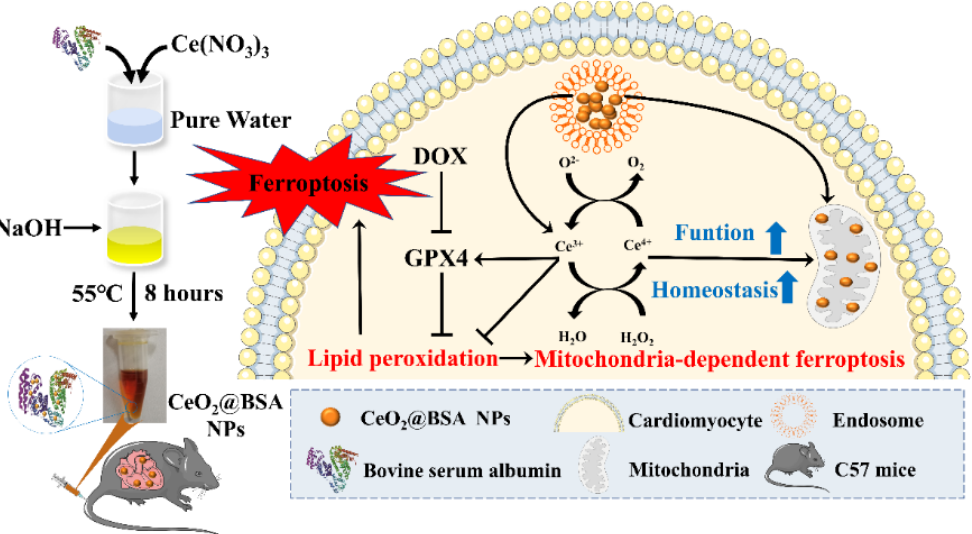
Figure 1. Scheme of biomimetic cerium-oxide-based nanozyme synthesis by biomineralization. After tail vein injection, the nanozymes were taken up by the cardiomyocytes and mitochondria, activating the GPX4 to reverse ferroptosis by maintaining mitochondrial function and homeostasis. BSA: bovine serum protein, NPs: nanoparticles, DOX: doxorubicin, GPX4: glutathione peroxidase